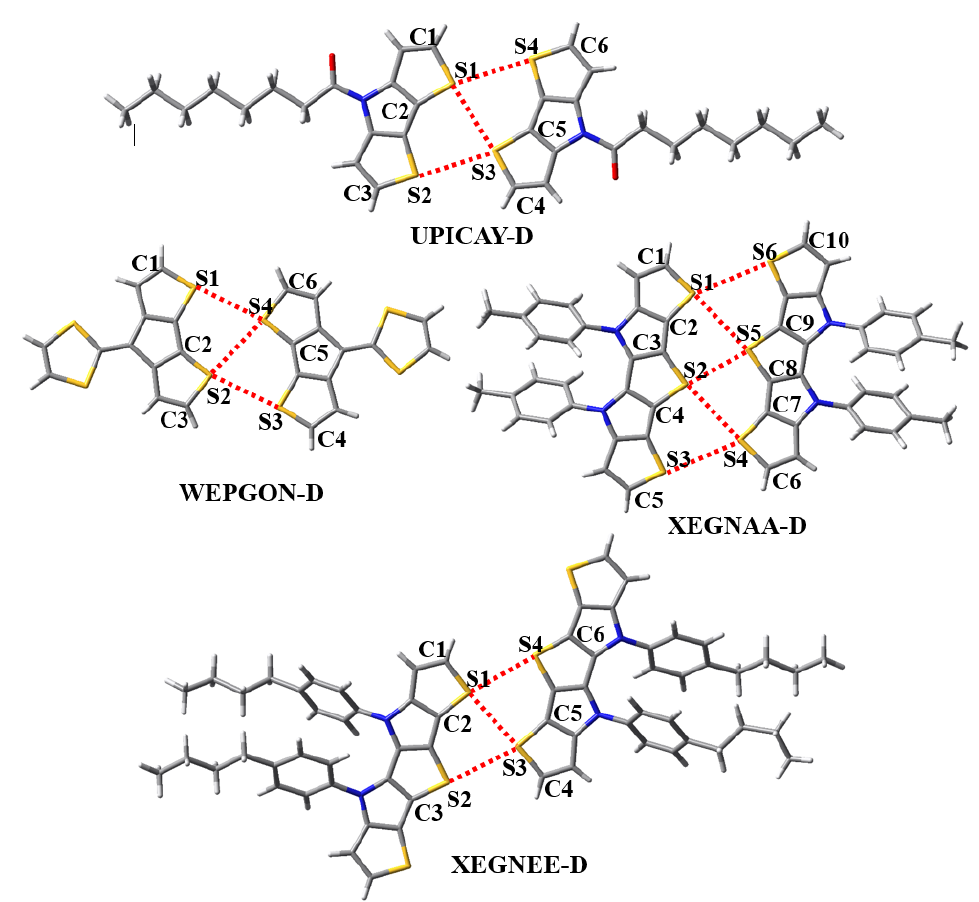
Figure 5. The bifurcated σ-hole···σ-hole stacking interactions (red dashed lines) in the dimers UPICAY-D, WEPGON-D, XEGNAA-D and XEGNEE-D. The N atom is shown in dark blue; O is shown in red and H is in white.